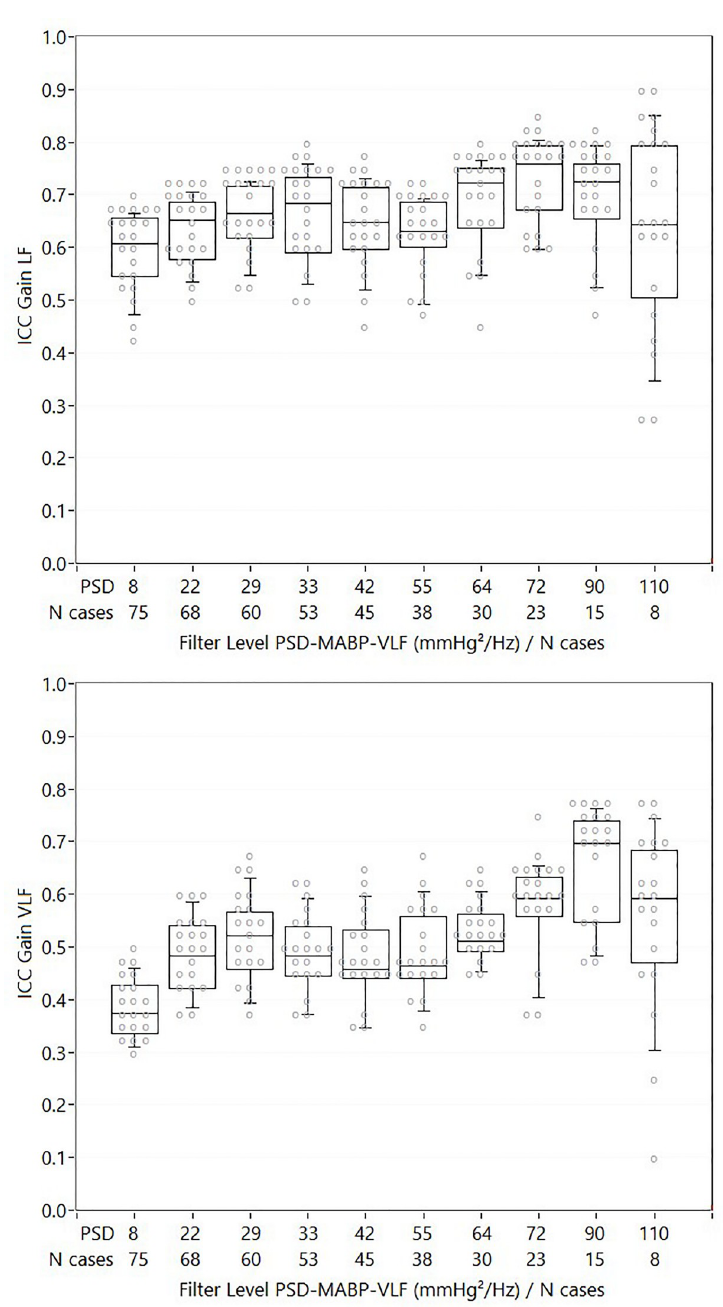
Fig 3. ICC values for gain LF and gain VLF. Beeswarm boxplot with ICC values for gain LF (upper figure) and gain VLF (lower figure) for different cut-off levels of PSD-MABP. Each grey dot represents an analysis method. No significant differences between methods were found. The increase in ICC with increasing cut-off levels was significant for both gain LF and gain